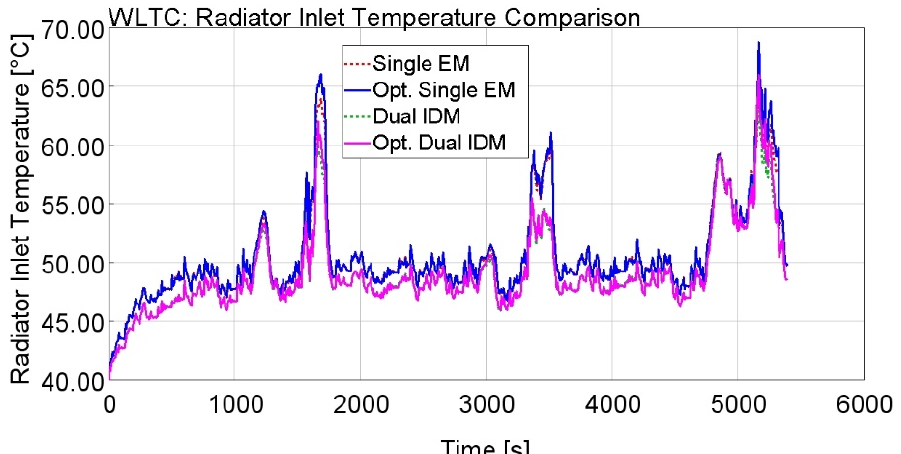
Figure 18. Impact of modularity and optimized control strategy on the coolant temperature at the radiator inlet for the WLTC driving cycle.